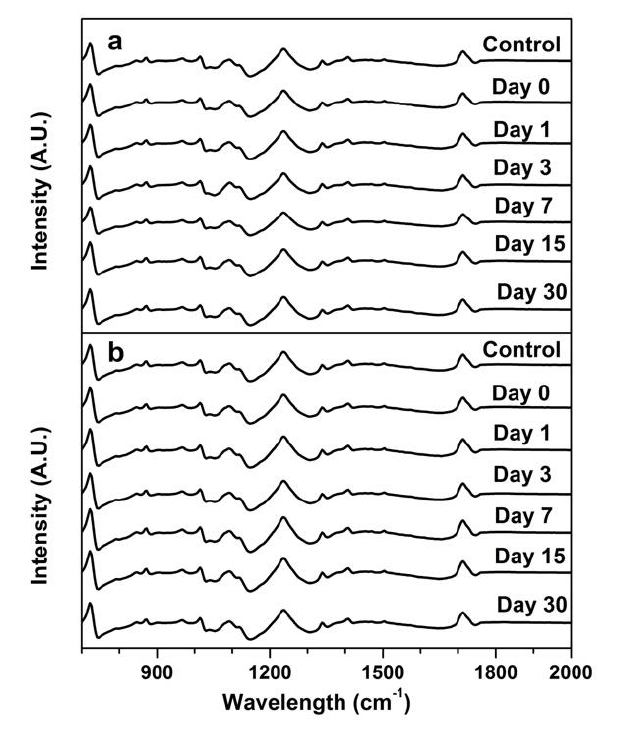
Figure A7. ATR-FTIR spectra of control ( a ) and plasma-treated ( b ) W1 (polyester) in the range between 700 and 2000 cm − 1 .